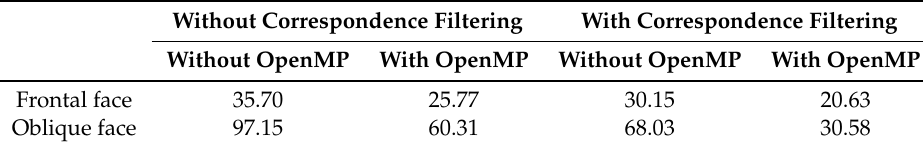
Table 1. Processing time (ms) for face model fitting without and with acceleration.